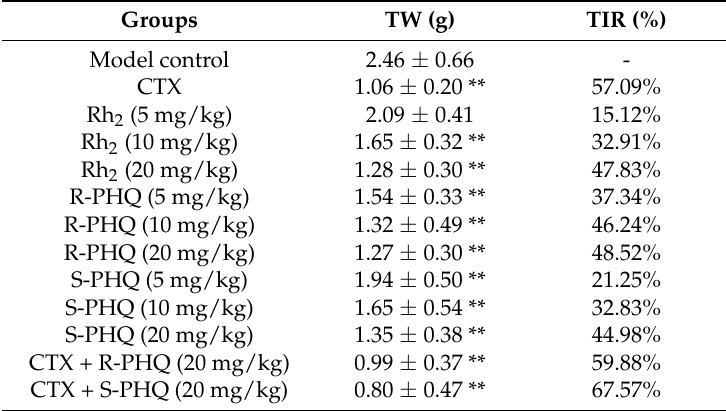
Table 1. Tumor weight and inhibition rate of tumor growth on H22 tumor-bearing mice.